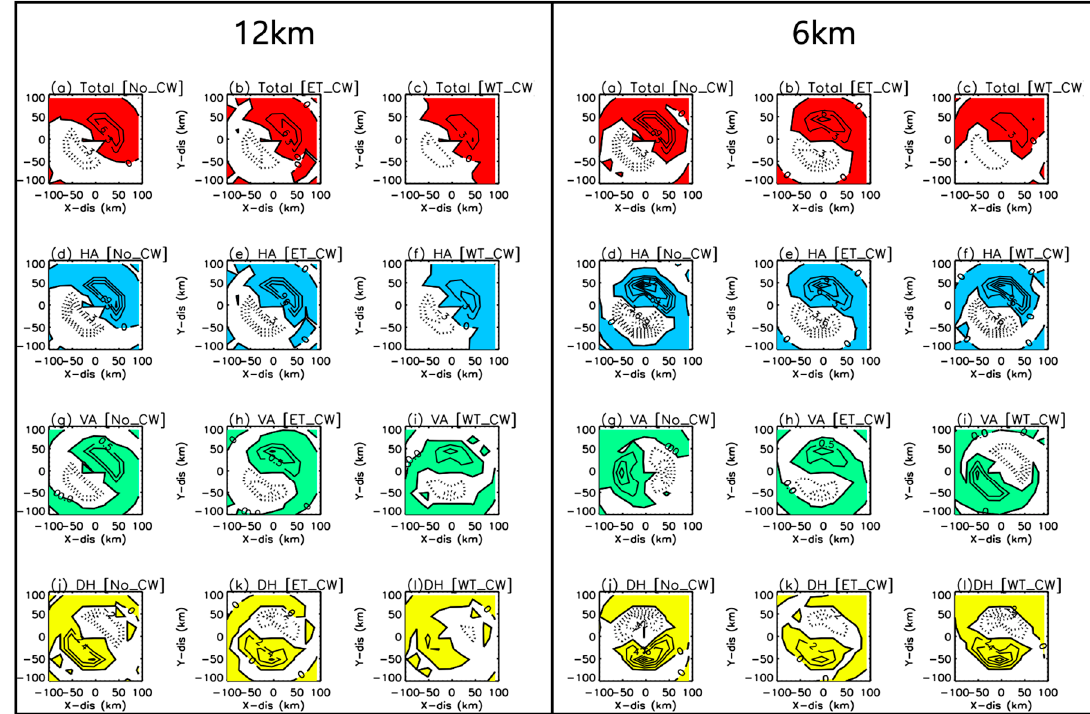
Figure 5. Wavenumber-1 components of ( a – c ) total potential vorticity tendency, ( d – f ) horizontal advection, ( g – i ) vertical advection, and ( j – l ) diabatic heating, which are 12-h composites of lower-level (0.9 ≥ σ ≥ 0.55) averages during 48–60 h in (left) No_CW, (middle) ET-CW, and (right) WT-CW experiment of Tembin. The left panel is for 12 km grid experiments and the right panel is for 6 km grid experiments. Positive values are shaded. The contour interval is 3.0 in ( a – f ), 0.5 in ( g – i ), and 1.0 in ( j – l ). [Unit: 10 − 4 potential vorticity unit (PVU) per seconds (PVU, where PVU:10 − 6 m 2 s − 1 Kkg − 1